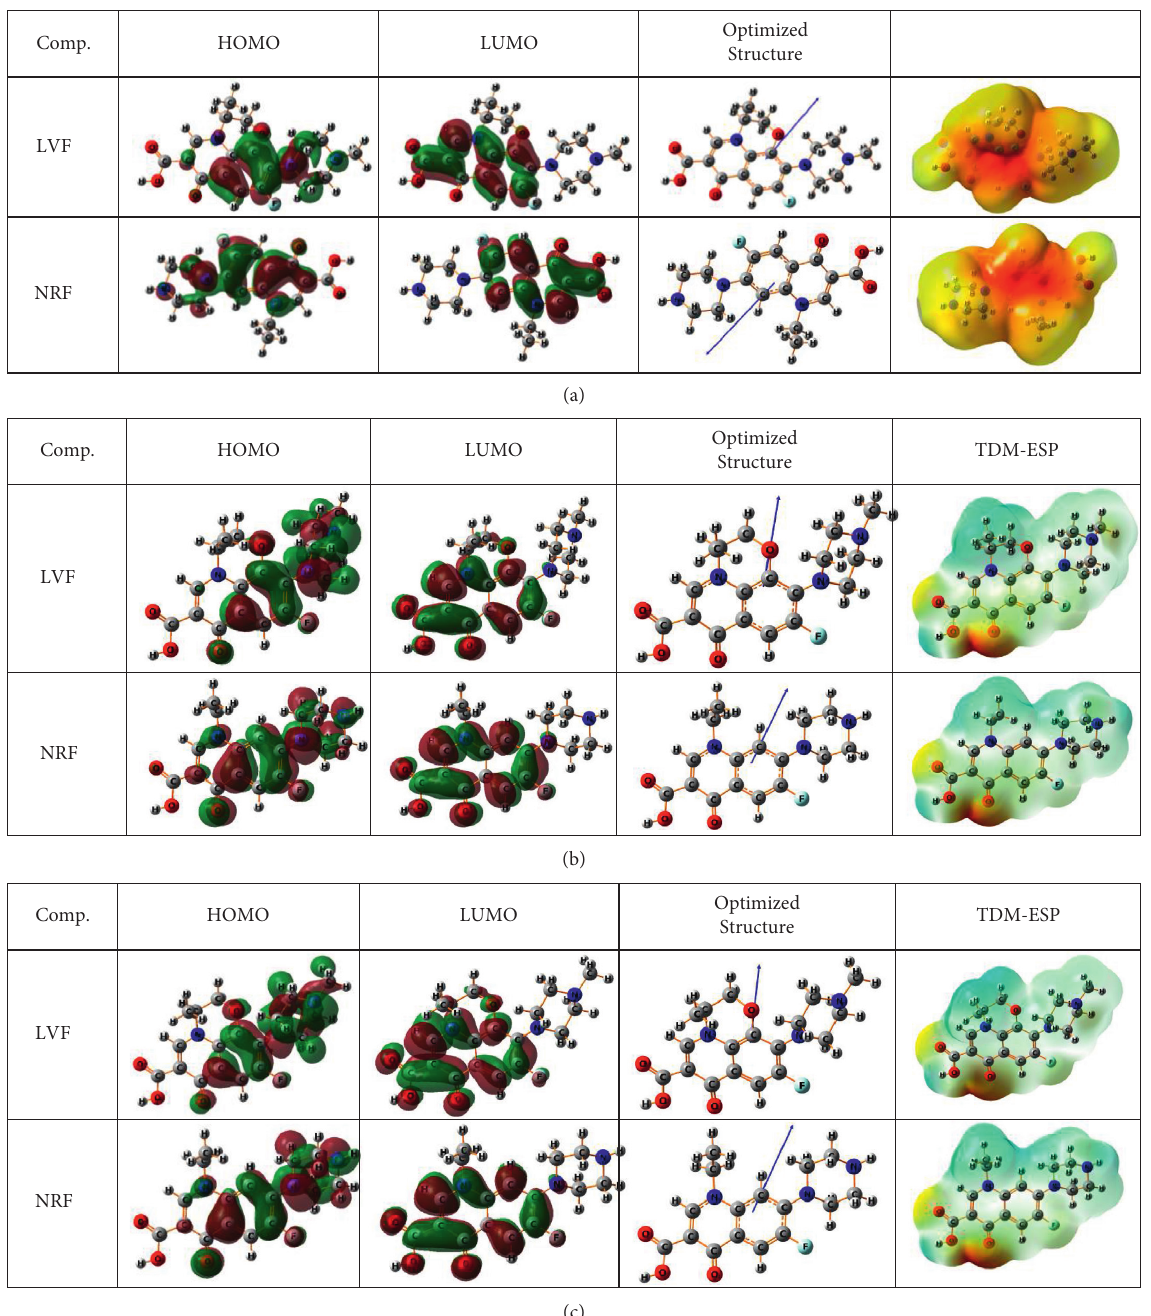
Figure 7: The HOMO-LUMO structures, optimized structure with dipole moment vector and total density matrix with electrostatic potential map (TDM-ESP) for LFV and NRF using (a) semiempirical method MP6, (b) DFT-B3LYP-3-21G, and (c).